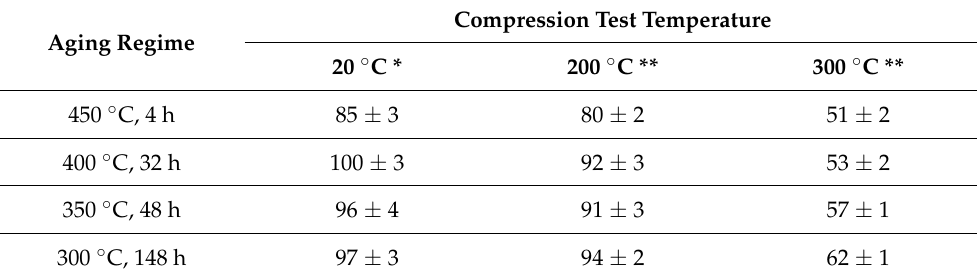
Table 1. Yield strength (MPa) at different compression temperatures of the alloys studied after aging of as-cast alloy (error bars are the standard deviation of a mean value).